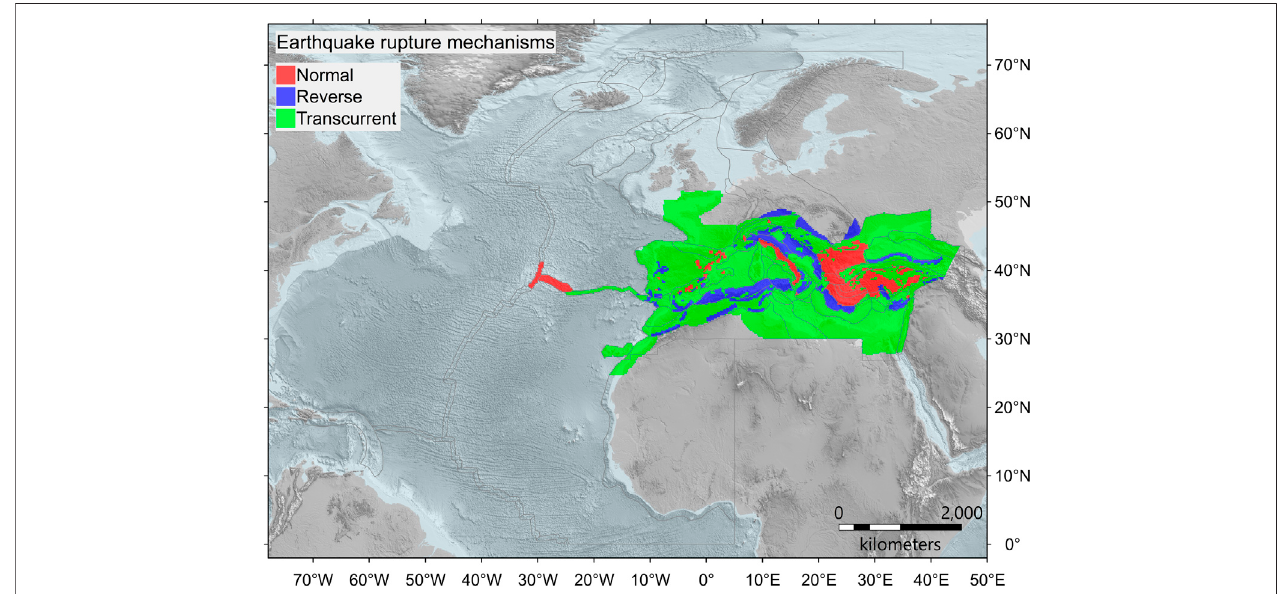
FIGURE 9 | Geographic distribution of crustal earthquake rupture mechanisms within the calculation domain for the BS/SPS type. Only the most probable mechanism in each grid cell is shown for simplicity. The complete distribution consists of strike discretization at four intervals of 45 ° starting from 22.5 ° clockwise from North,anddipdiscretizationatnineintervalsof20 ° withinthe0 ° – 180 ° range.Therakediscretizationisatfourintervalsof90 ° ,correspondingtonormal,reverse,left-lateral strike-slip, and right-lateral strike-slip. Altogether, this makes a total of 4 × 9 × 4 (cid:3) 144 combinations of the strike, dip, and rake values. For the SBS type ( Figure6D ),thevariabilityofthemechanismislimitedtofourcombinations(strikeof22.5 ° and337.5 ° ;dipat10 ° and30 ° ,andrake fi xedat90 ° ).Topo-bathymetryisfrom the ETOPO1 Global Relief Model (NOAA, 2009; Amante and Eakins,